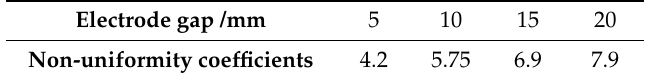
Table 1. Non-uniformity coefficients under different electrode distances. 117